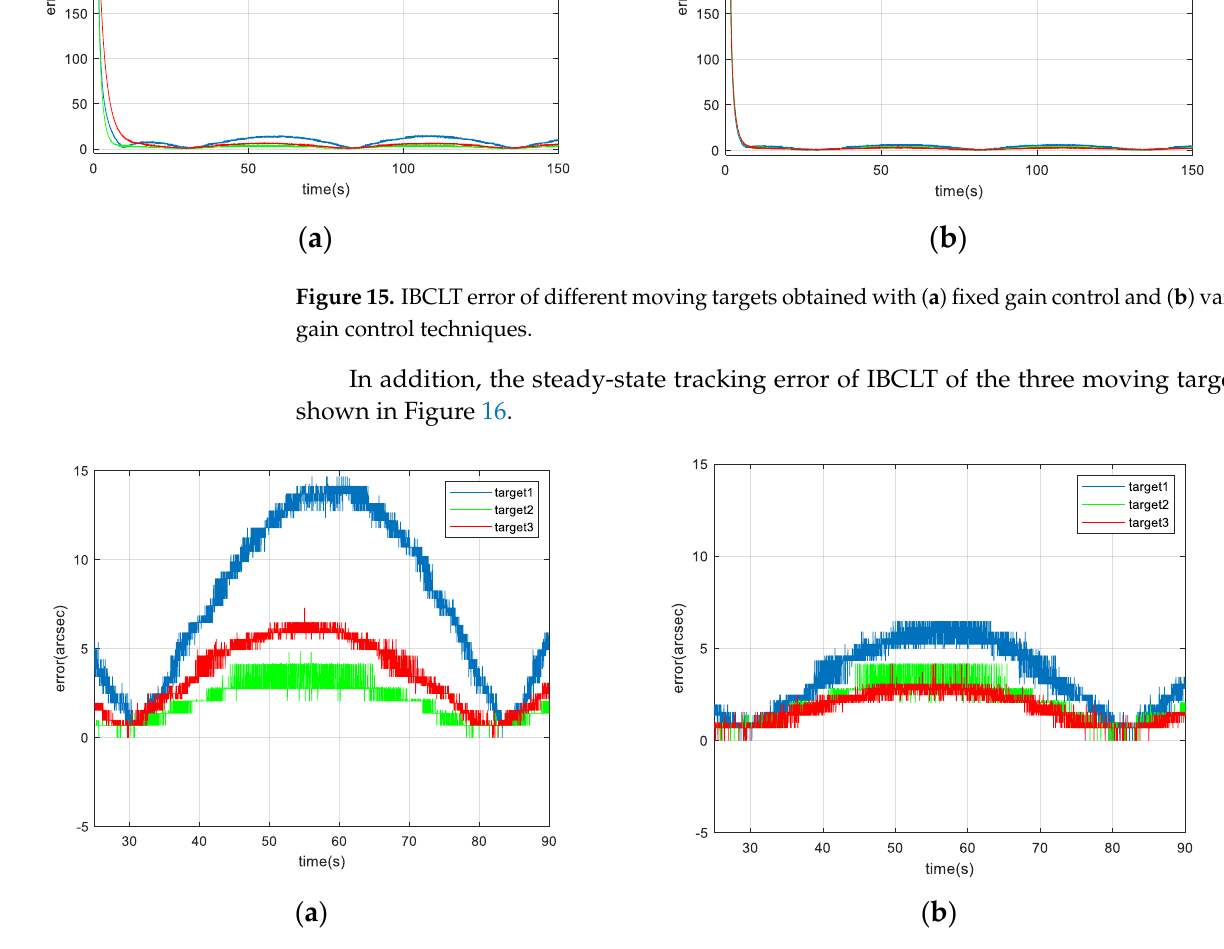
Figure 16. Local amplification of steady-state error in IBCLT of different moving targets: ( a ) fixed gain control and ( b ) variable gain control. Table 3. Steady-state tracking errors of different moving targets.